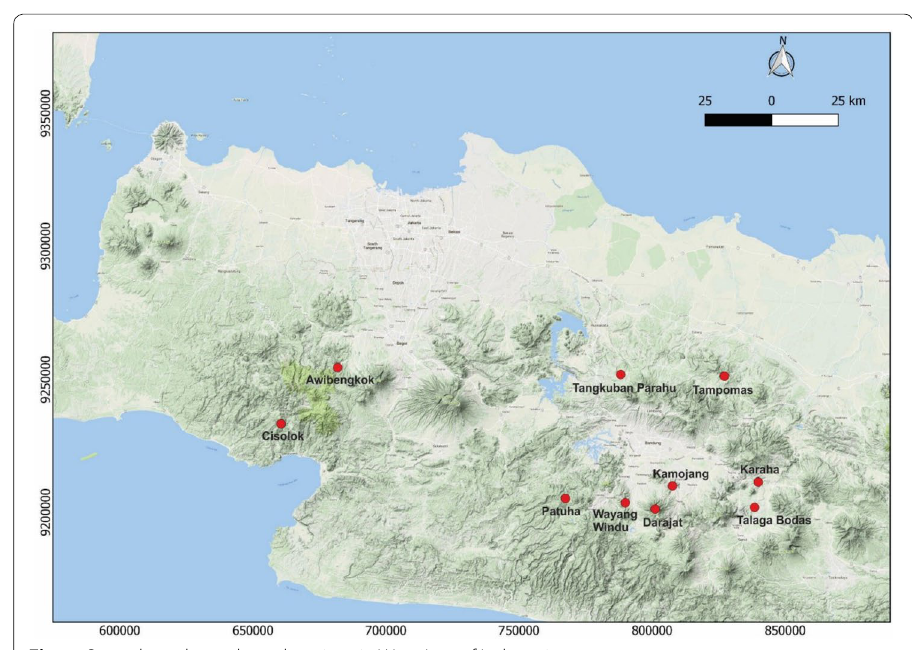
Fig. 1 Several geothermal area locations in West Java of